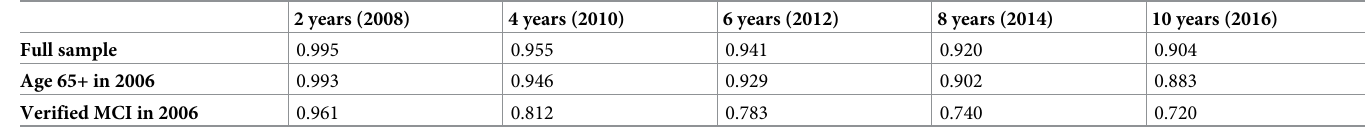
Table 6. Area under the receiver operating characteristics curve (AUROC) for predicting dementia or dead with dementia for 2, 4, 6, 8 and 10